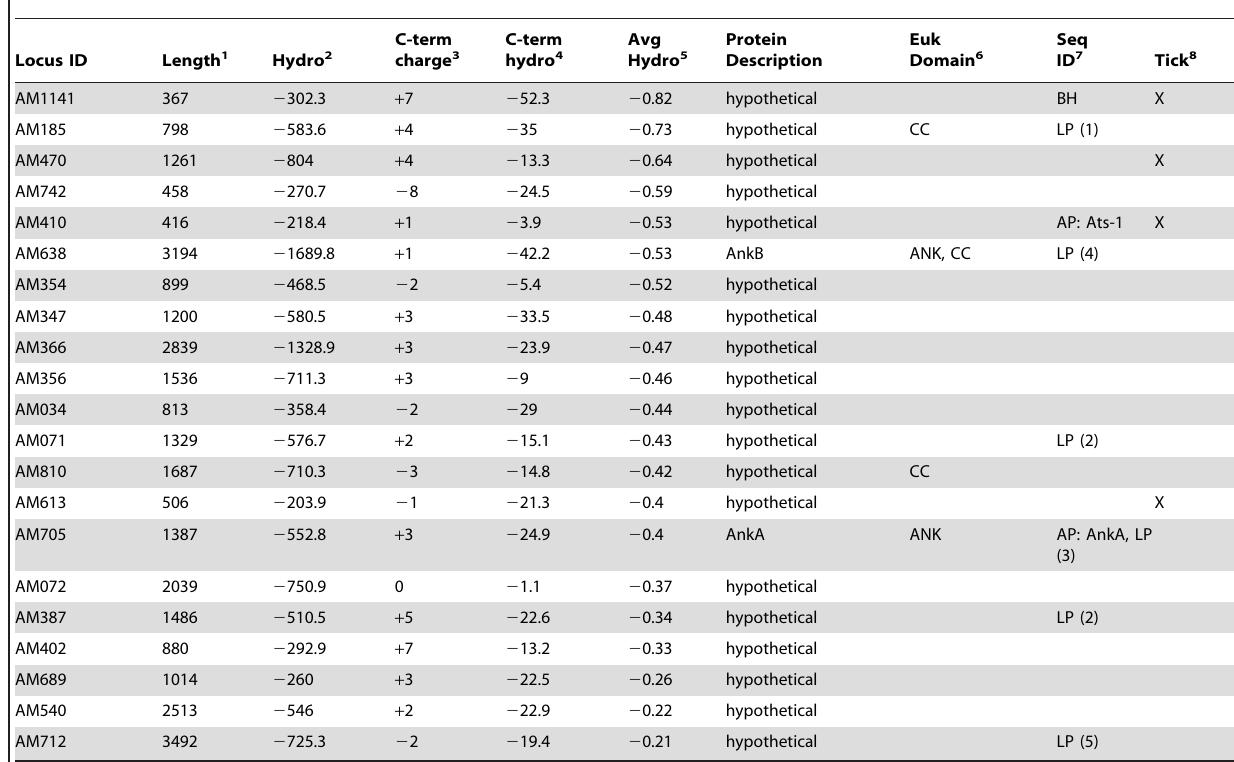
Table 1. Predicted A. marginale effector proteins.